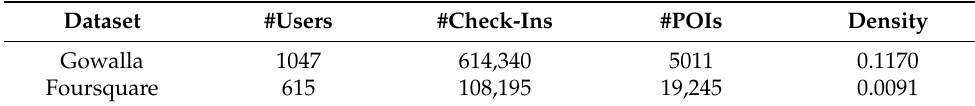
Table 3. Statistics of the two datasets.